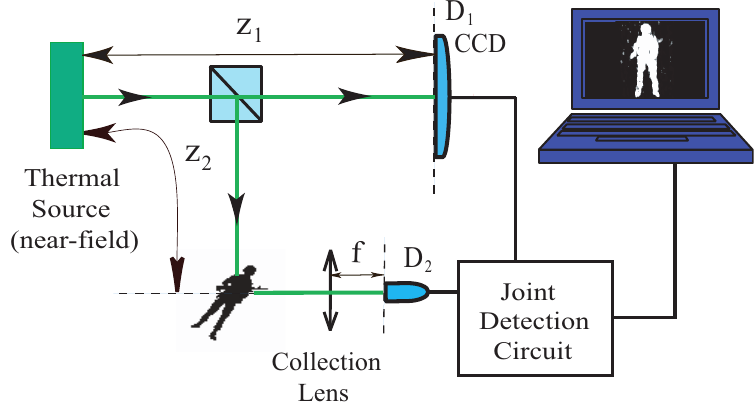
Figure 4. Lensless ghost imaging of chaotic-thermal light demonstrated by Meyers et al. in 2008. D 2 is a “bucket” photon counting detector that is used to collect and count all random scattered and reflected photons from the object. The photon number fluctuation correlation between the “bucket detector” ( D 2 ) and the CCD array ( D 1 ) is measured and calculated by a photon-counting-coincidence circuit, similar to the PNFC circuit described in the last section. The counting rate of D 2 and each element of the CCD array of D 1 were both monitored to be constants during the measurement (the consistent value is mainly determined by the source intensity). Surprisingly, a ghost image of the object was (cid:82) d (cid:126) ρ 2 ∆ n ( (cid:126) ρ 2 ) (cid:105) between the CCD and captured in the photon number fluctuation correlation (cid:104) ∆ n ( (cid:126) ρ 1 ) D 2 , when taking z 1 = z 2 . The images “blurred” when the CCD is moved away from z 1 = z 2 , either to the direction of z 1 > z 2 or z 1 < z 2 . There is no doubt that thermal radiation propagates to any transverse plane in a random and chaotic manner. In the lensless setup, there is no lens applied to force the thermal radiation to “collapse” to a point or speckle either. What is the cause of the point-to-point image-forming